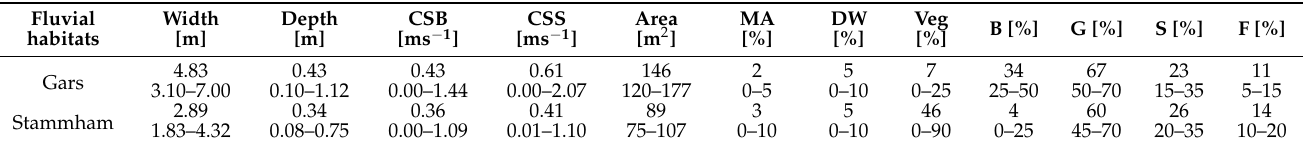
Table 2. Construction details of the fluvial habitats in Gars and Stammham. Values represent the mean and the range. CSB = current speed above bottom, CSS = current speed below surface, MA = submerged macrophytes in % coverage, DW = deadwood in % coverage, Veg = bank vegetation in % coverage. B = boulder in % coverage, G = gravel in % coverage, S = sand in % coverage, F = fines smaller 1 mm %